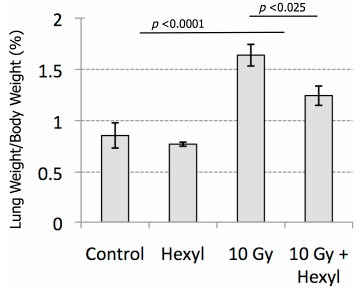
Figure 6. Mean lung weight at necropsy, by treatment group. The adverse main effect of irradiation is significant ( p < 0.0001), as is the beneficial effect of hexyl treatment ( p = 0.02418).